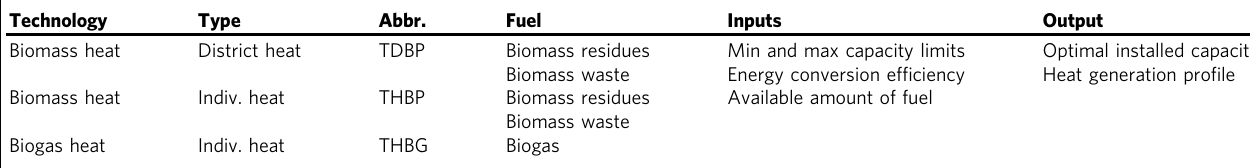
Table 6 Biomass-based heat generation